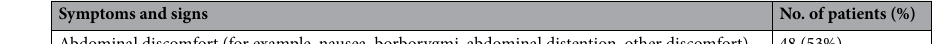
Symptoms and signs No. of patients (%) Abdominal discomfort (for example, nausea, borborygmi, abdominal distention, other discomfort) 48 (53%)